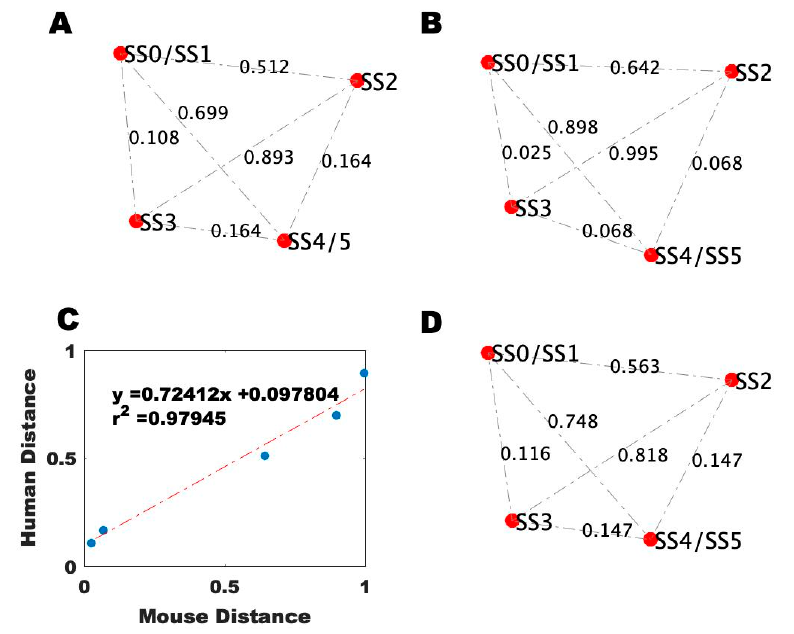
Figure 5. Reference blood profile topological network. ( A ) Topology of the distance between the simulated stable states using Brown’s method based on human healthy control data. ( B ) Topology of the distance between the simulated stable states using Brown’s method based on data from mice receiving a course of pure drinking water, an initial saline injection, and a follow-up injection of saline. ( C ) Regression of the human topology onto the mouse topology. ( D ) Topology of the distance between the simulated stable states using Brown’s method based on data from mice receiving a course of pure drinking water, an initial saline injection, and a follow-up injection of saline scaled to the human topology.